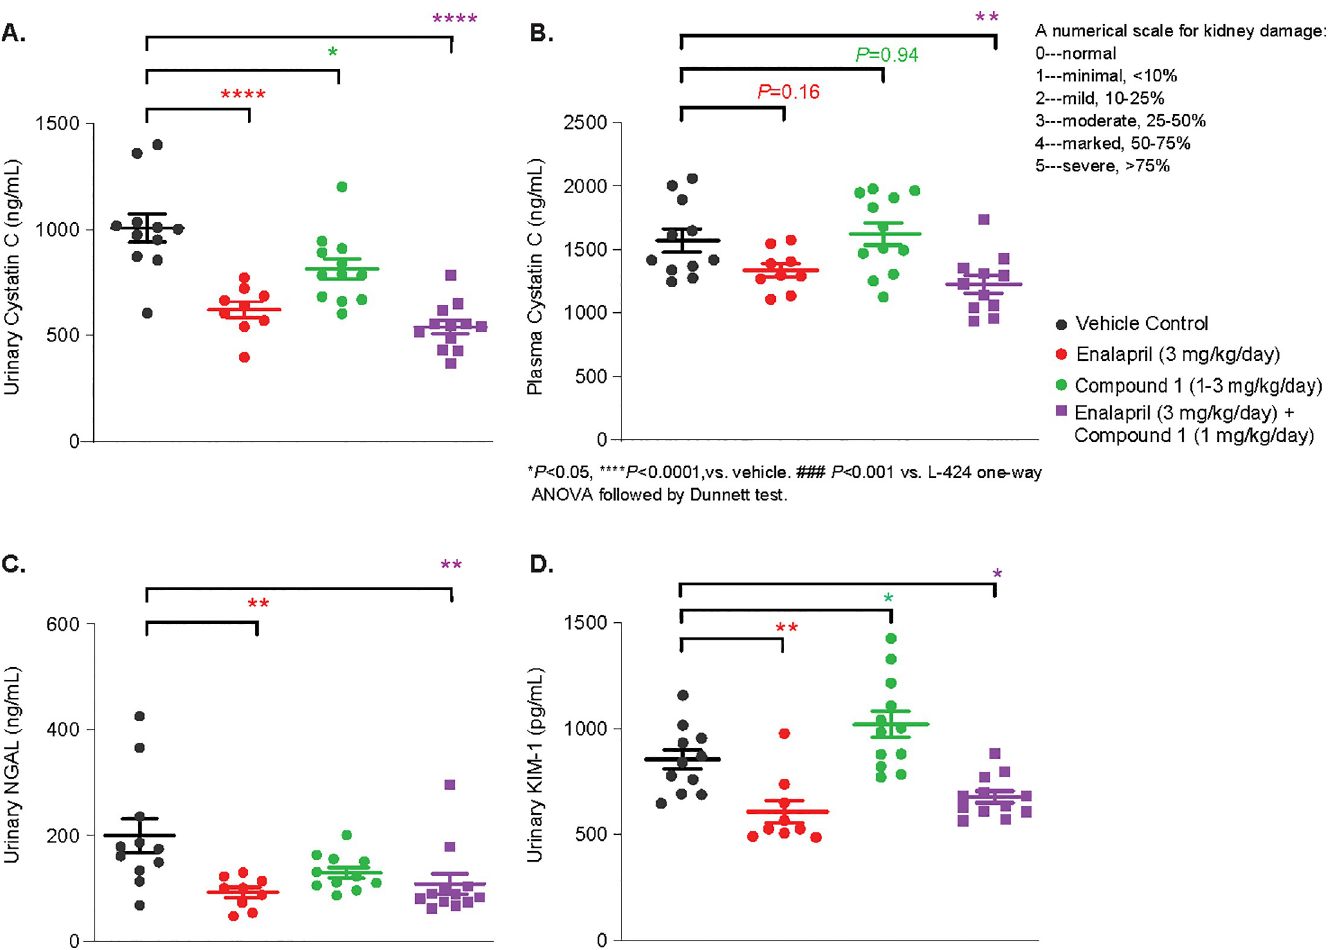
Fig 6. Effect of Compound 1 on plasma Cystatin C and urinary biomarkers. All 3 treated groups had reduced urinary Cystatin C concentration. (A) Only combination treatment significantly reduced plasma Cystatin C level. (B) Both Enalapril and combination treatments also reduced urinary NGAL (C) and (D) KIM-1. � P < 0.05, compared to Vehicle control. One-way ANOVA, followed by Dunnett’s test.